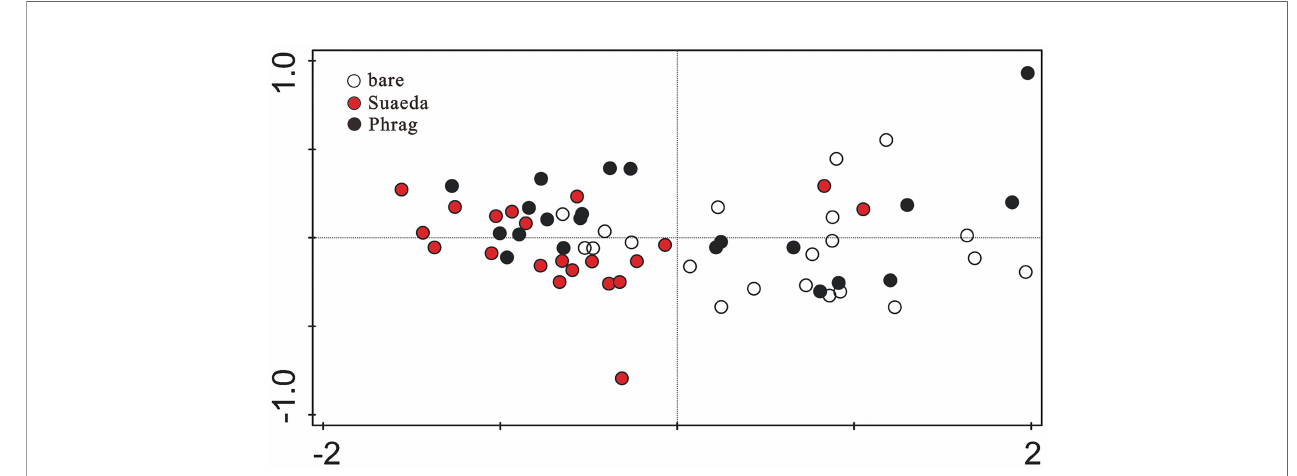
FIGURE 4 | Ordination graph of non-metric multidimensional scaling analysis using the Bray-Curtis coef fi cient of dissimilarity, based on mean values of element concentrations in soils. Wetland types of bare, Phrag, and Suaeda are represented by white, black and red circles,